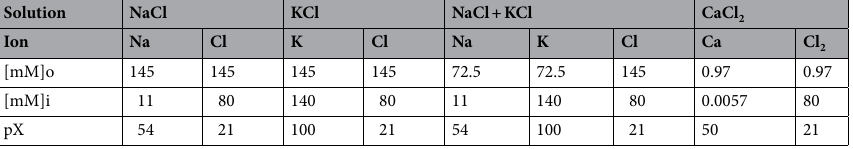
Table 3. Table of ion concentrations used in calculations. The ion concentrations used in GHK modelling to determine the membrane potential in different ionic